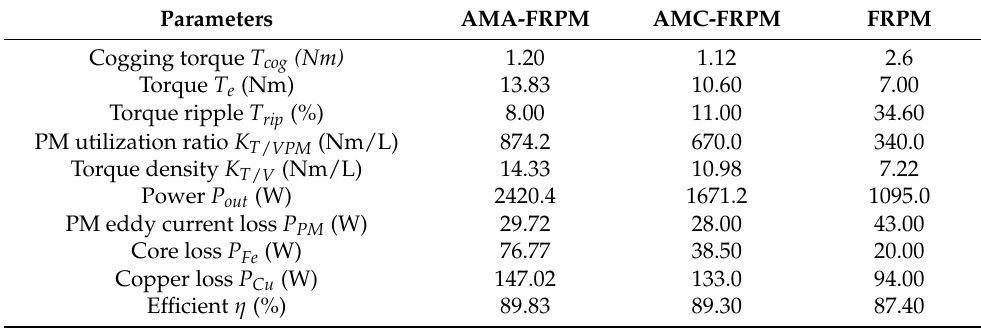
Table 3. Comparison of electromagnetic characteristics of AM-FRPM and FRPM